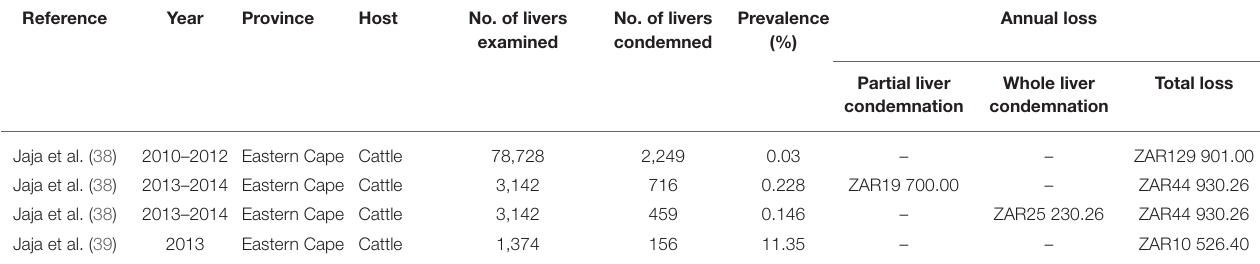
TABLE 4 | Information from reviewed publications on the economic burden due to liver condemnation caused by fasciolosis in cattle reported in South Africa.